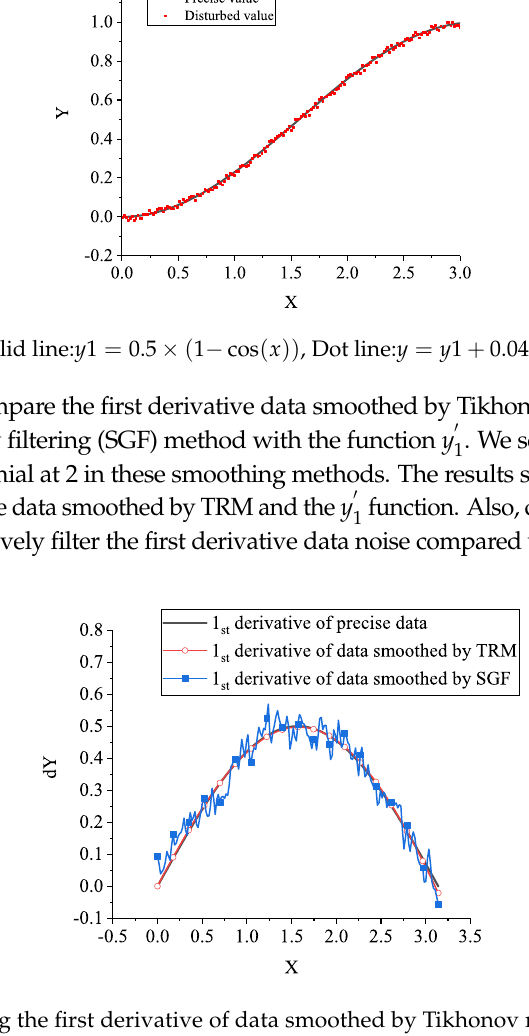
function (black 1